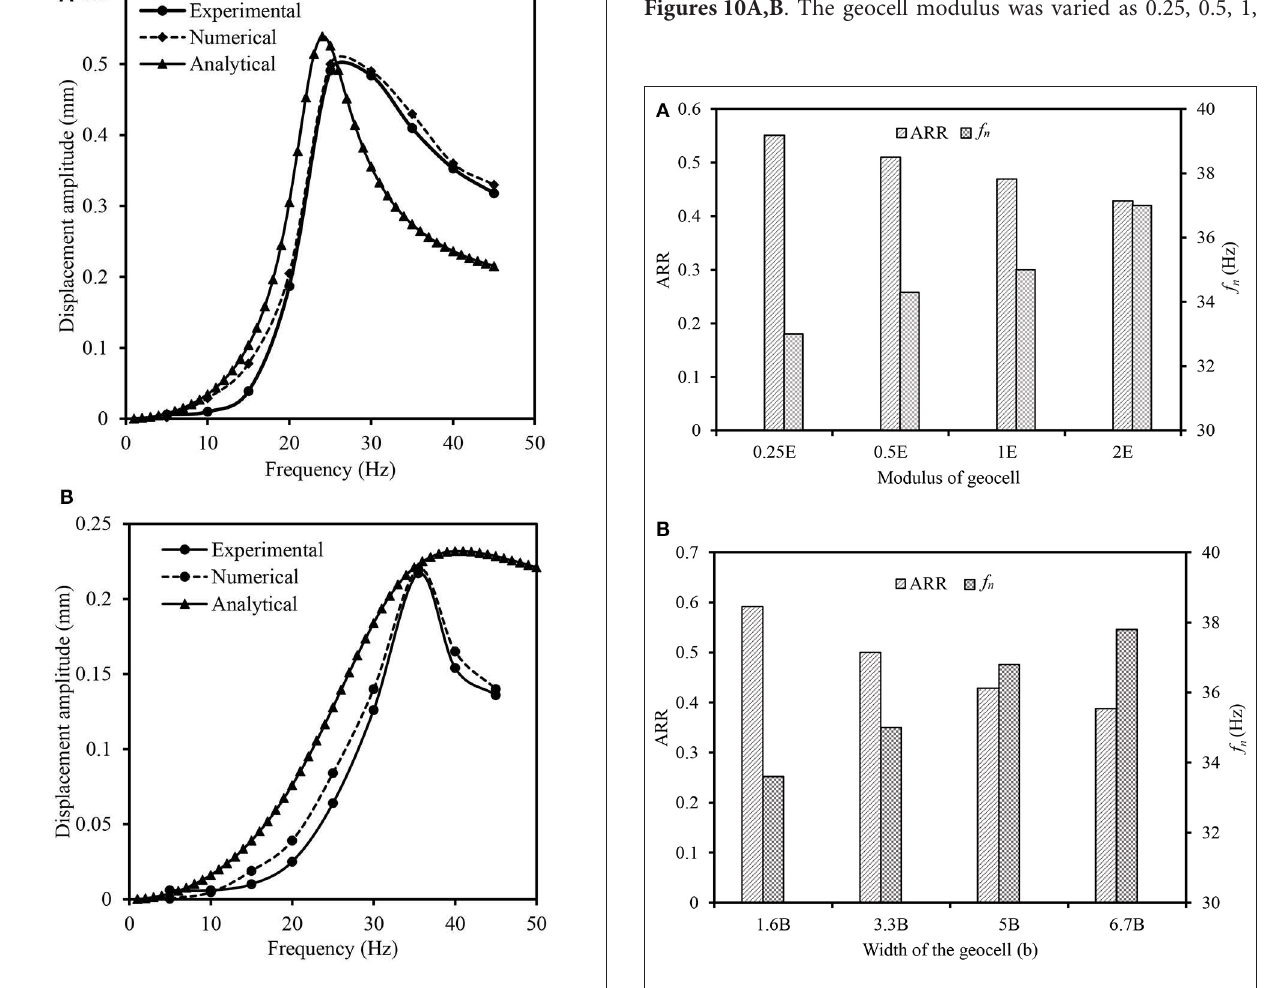
FIGURE 10 | Effect of geocell properties on ARR and f n : (A) geocell modulus; and (B) geocell